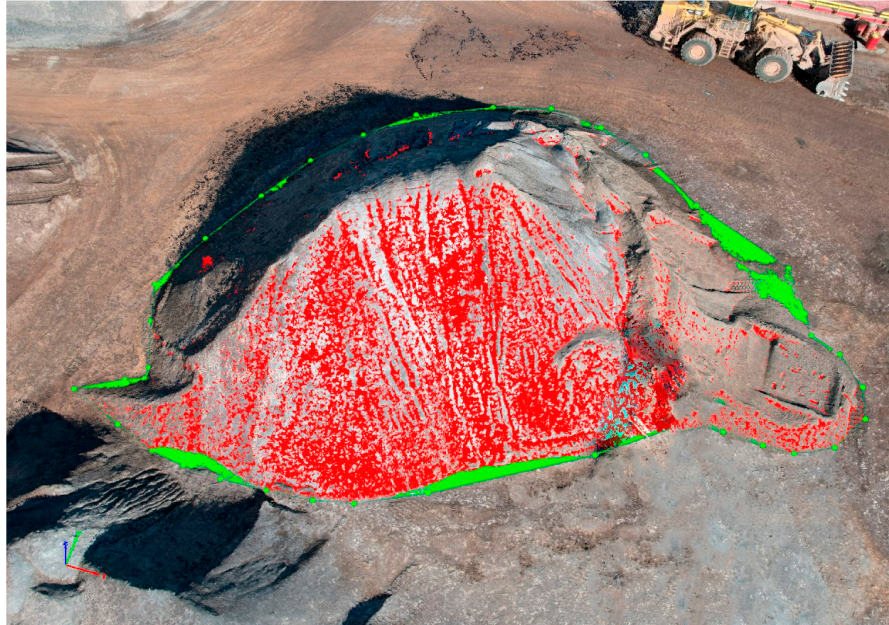
Figure 7. Stockpile Volume Calculation in point cloud model at Quarry Site. Table 5. Results of volume calculation from the case study.